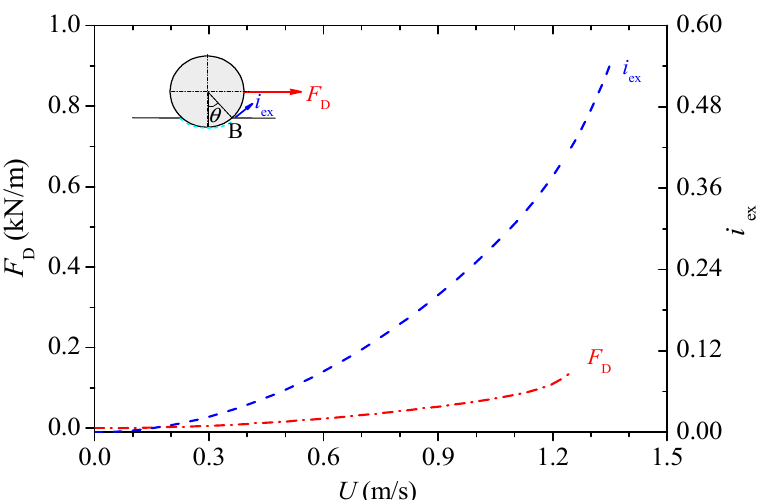
Figure 8. Variations of the drag force on the pipe ( F D ) and the maximum upward hydraulic gradient ( i ex ) with the inflow velocity ( U ).